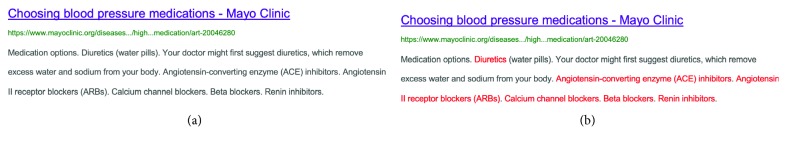
Example search results with removed highlighting terms from Google (a) and an annotated user (b) for the same query and snippet.